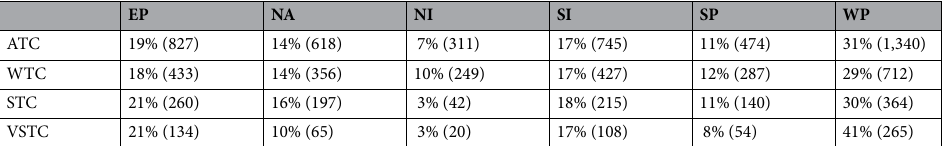
Table 1. Tropical cyclone (TC) occurrences from 1980–2019 by basin and intensity. Percentages are per intensity classification (i.e. all percentages in the All Tropical Cyclone (ATC) category add to 100%) and the numbers in parenthesis are the totals. WTC, STC, and VSTC stand for Weak, Strong, and Very Strong TCs, respectively.